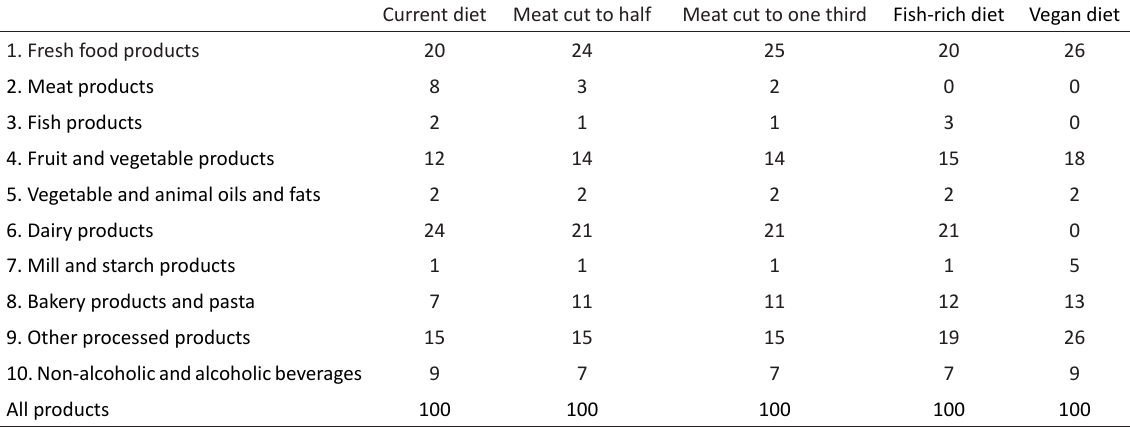
Table 1. Percentage of food products consumed (in kilograms) by product categories used in the input-output analysis for the current and alternative diets